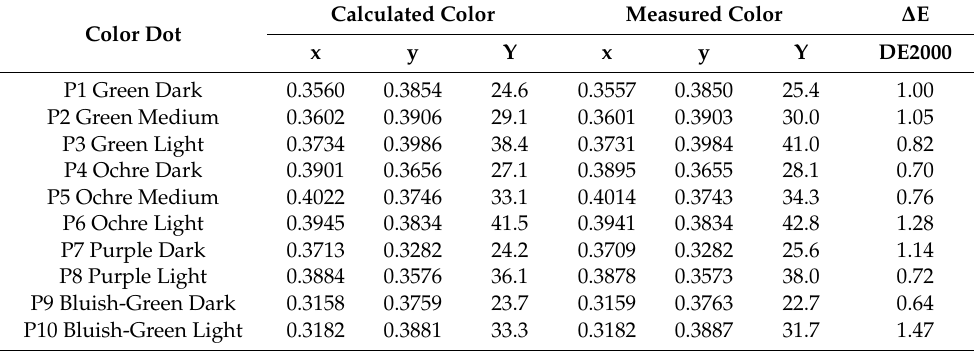
Table 5. Chromatic coordinates calculated from the hyperspectral image and measured from the virtual reality scene for 10 di ff erent color dots of Ishihara Test plate number